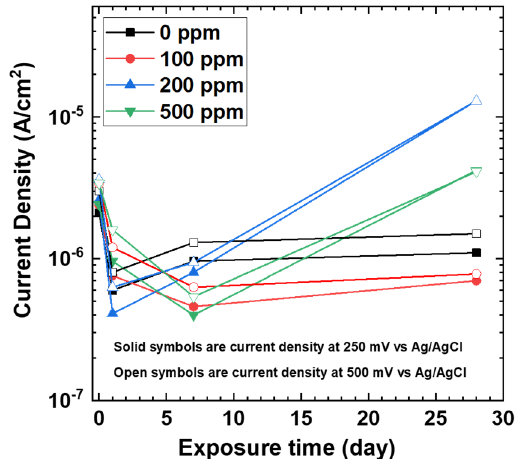
Figure 11. Current density profiles taken at 250 and 500 mV vs. Ag/AgCl as a function of chloride concentrations and exposure days in engine coolants.